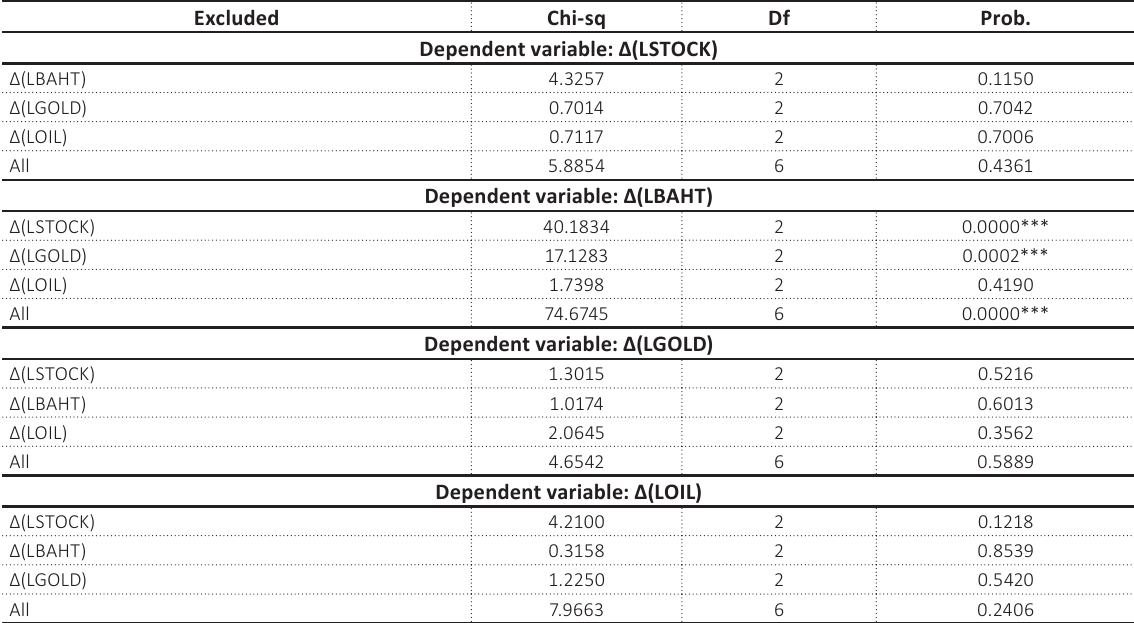
Table 6. VECM short-run Granger